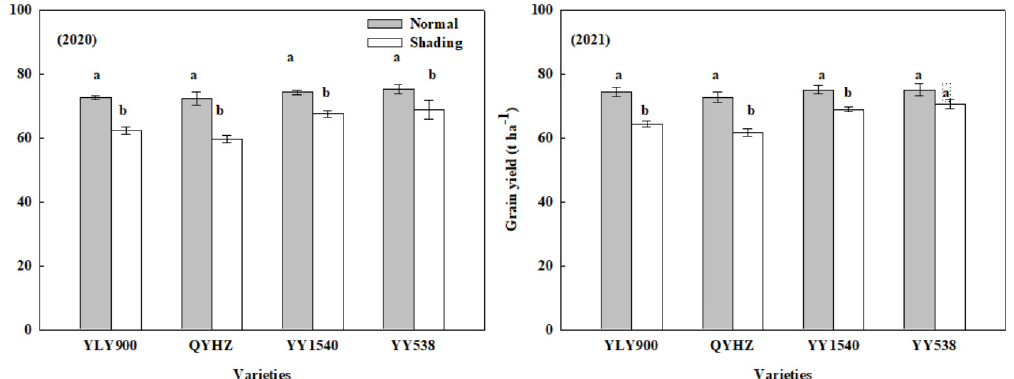
Figure 4. Taste values of different rice varieties under shading after flowering in 2020–2021. YLY900 (Y-liangyou 900); QYHZ (Quanyouhuazhan); YY1540 (Yongyou 1540); YY538 (Yongyou 538). Different lowercase letters indicate significant differences at p < 0.05 between normal and shading according to LSD at 0.05 level.